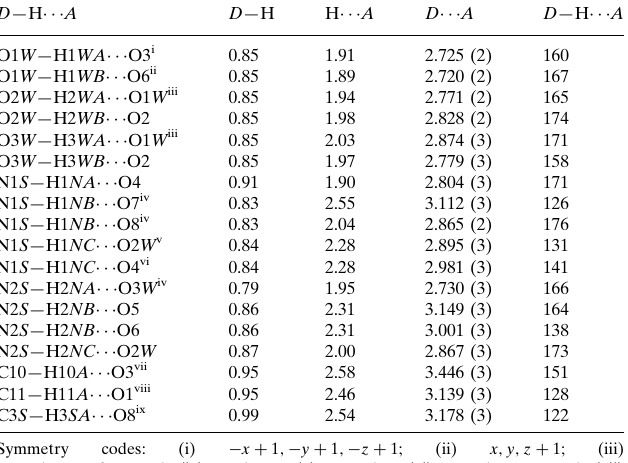
Hydrogen-bond geometry (A˚ , (cid:3)